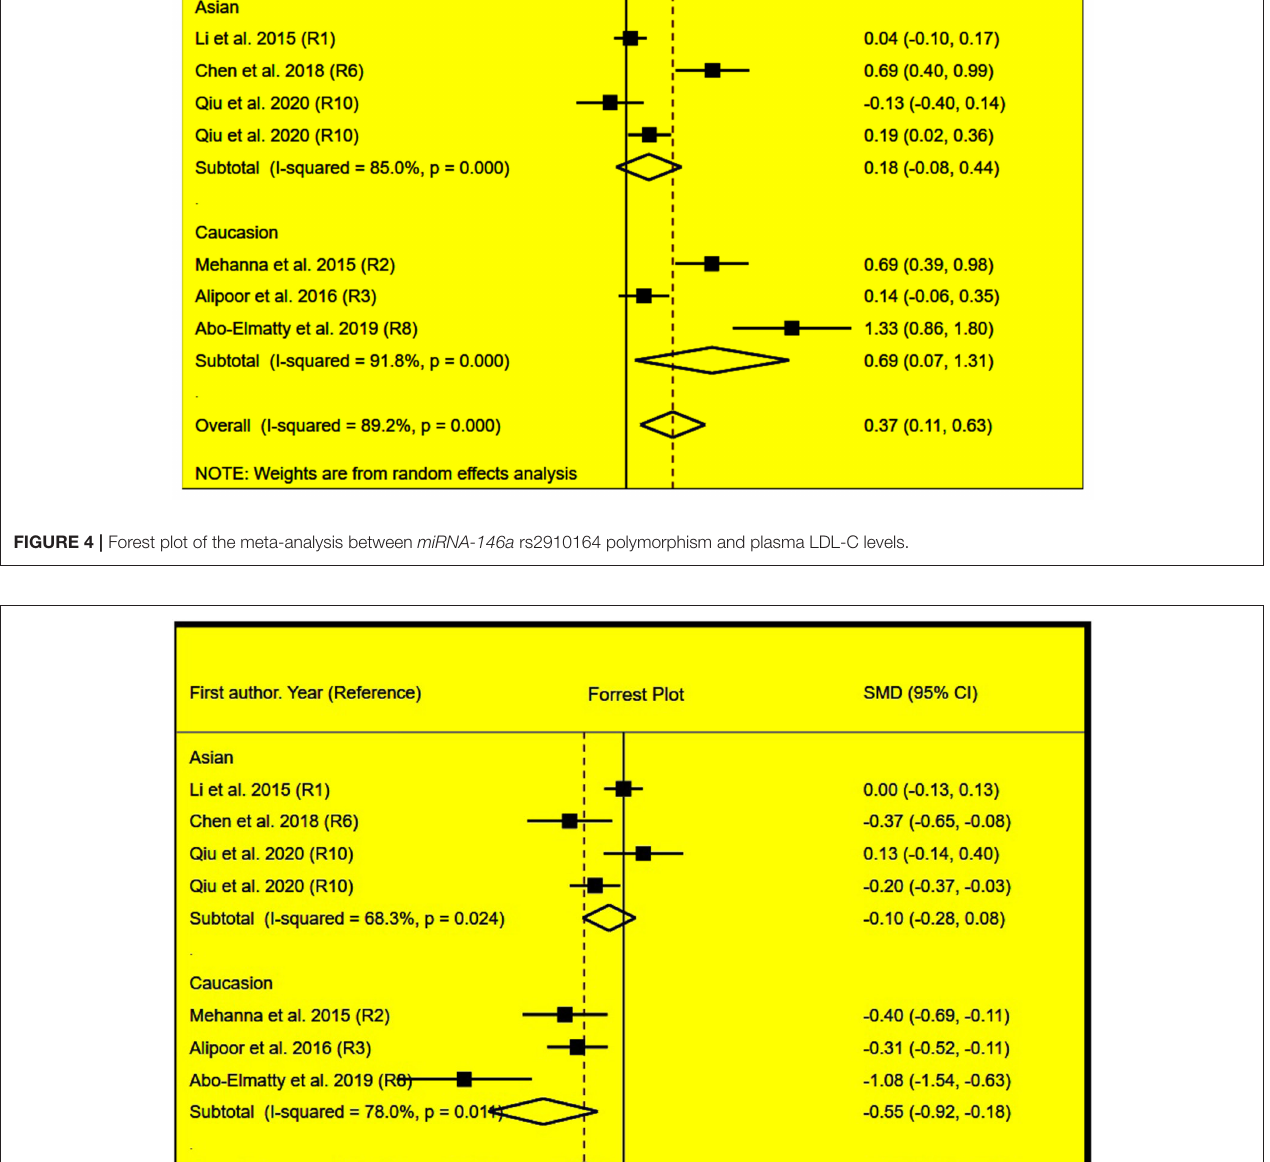
three (Mehanna et al., 2015; Chen et al., 2018; Abo-Elmatty and Mehanna, 2019), and three (Li et al., 2015a; Abo-Elmatty and Mehanna, 2019; Qiu et al., 2020) comparisons were recognized